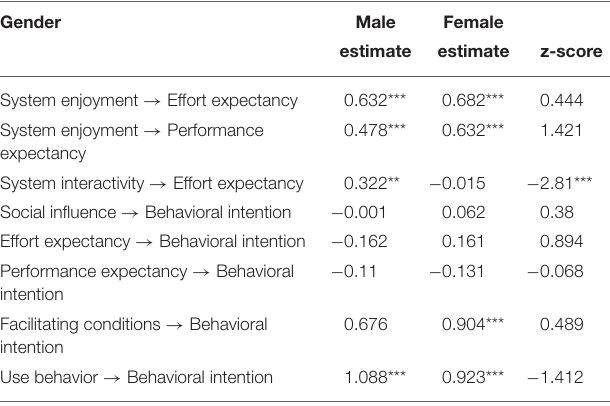
TABLE 6 | Effects of moderating